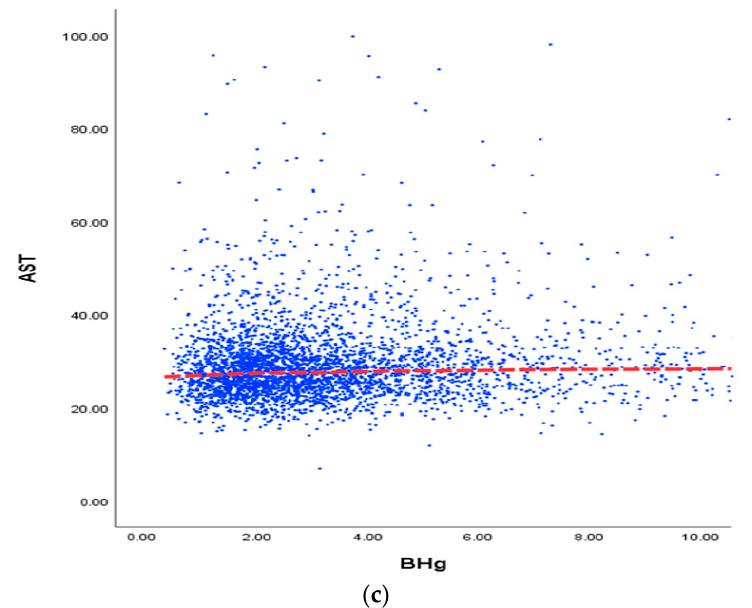
Figure 1. ( a ) . Relationship between blood levels of Hg (mercury). ( b ). Relationship between blood levels of Hg and liver enzyme (ALT) in adults (before adjustment). And liver enzyme (AST) in adults (before adjustment). ( c ). Relationship between blood levels of Hg and liver enzymes in adults (after adjustment). The smoothing line is fitted by using the LOESS regression model, adjusted for gender (in all), age, and smoking, alcohol consumption, obesity and exercise. BHg, Blood mercury; AST, aspartate aminotransferases; ALT, alanine transaminase.